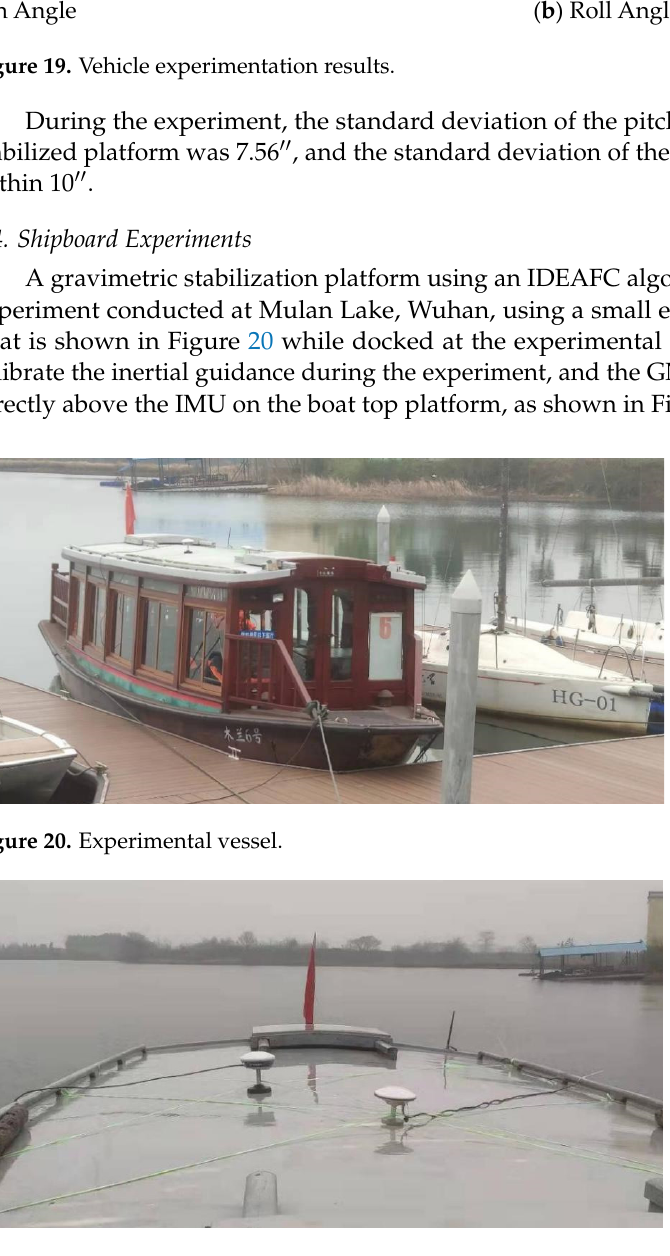
Figure 21. Installation position of GNSS antenna.